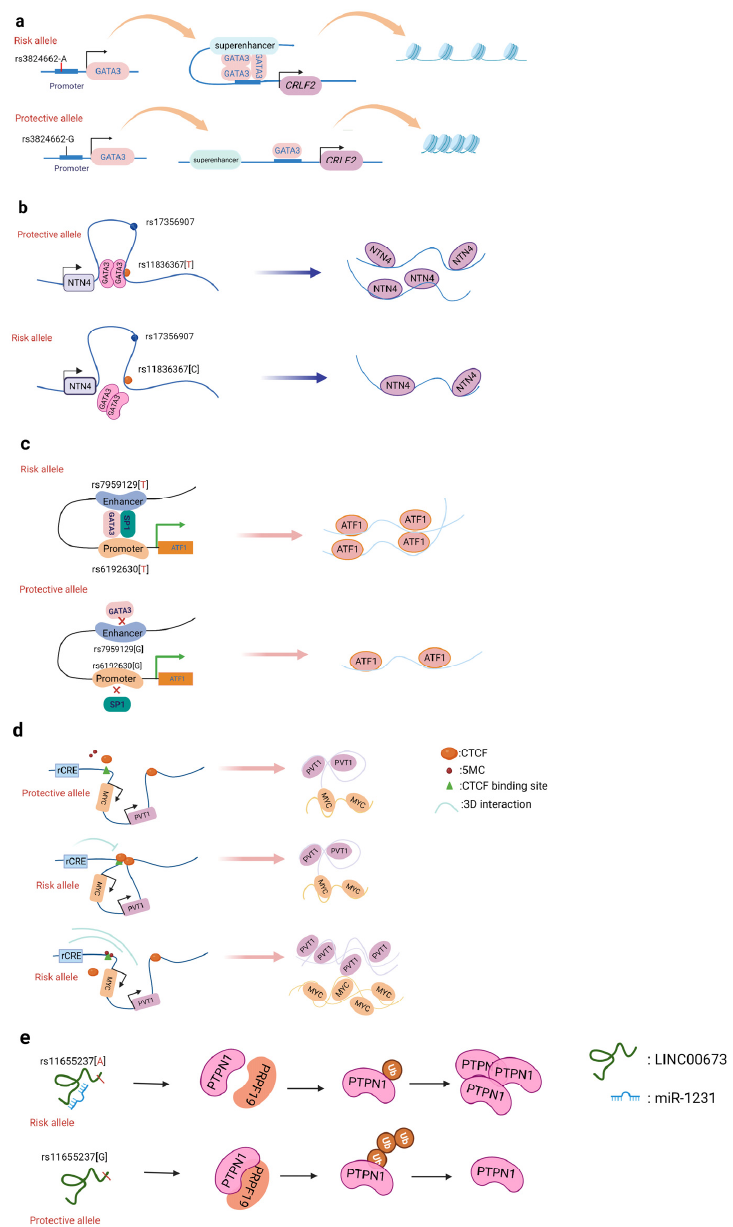
Figure 2. Schematic diagram of the action mechanism employed by non-coding SNPs. ( a ) The SNP rs3824662 allele A increases chromatin accessibility by inducing GATA3 expression, promoting the binding of GATA3 with the CRLF promoter, and ultimately forming a chromatin loop. ( b ) The NTN4 enhancer risk variant rs11836367 binds to the TF GATA3 to regulate NTN4 expression, ultimately promoting breast carcinoma initiation and progression. ( c ) Enhancer SNP rs7959129 risk allele G interacts with promoter SNP rs6192603 risk allele G contributing to ATF1 expression by binding TFs GATA3 and SP1. ( d ) The risk allele rs11986220 and higher methylation at –10 Kb synergistically function to confer a greater risk of tumor; however, when -20 Kb is hypomethylated, the function of the risk SNP is inhibited by the enhancer-blocking insulator loop mediated by CTCF. ( e ) The risk variant rs11655237 in LINC00673 creates a miR-1231–binding site that interferes with the expression of LINC00673 and contributes to pancreatic cancer